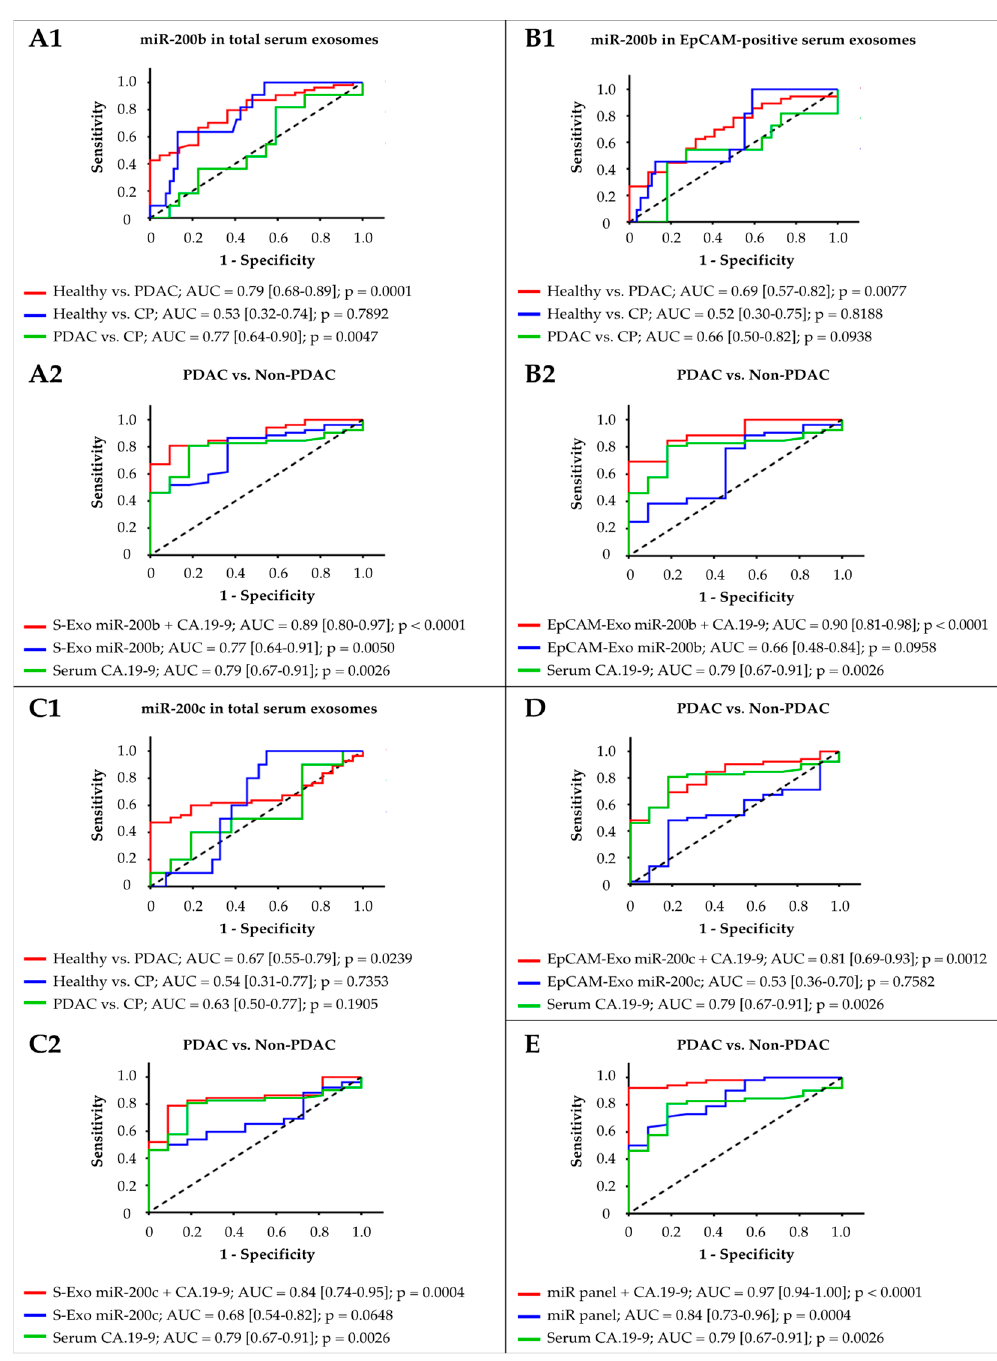
Figure 2. Receiver operating characteristic curve analysis for discrimination between (1) healthy, chronic pancreatitis, and PDAC, as well as (2) PDAC and non-PDAC, in comparison to and in combination with CA.19-9. ( A ) MiR-200b from total serum exosomes, ( B ) miR-200b from EpCAM-positive serum exosomes, ( C ) miR-200c from total serum exosomes, and ( D ) miR-200c from EpCAM-positive serum exosomes. ( E ) Diagnostic potential of a biomarker panel consisting of all four exosome fractions in comparison to and in combination with CA.19-9. AUC, area under the ROC curve.